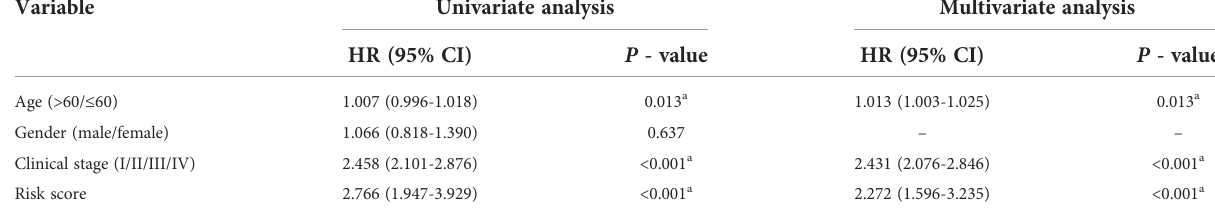
TABLE 2 Univariate and multivariate Cox regression analyses of clinicopathologic characteristics associated with overall survival in the GSE63354-GSE85459 cohort.